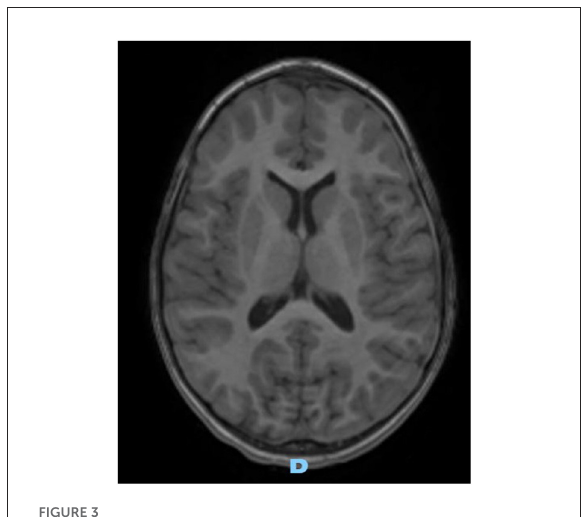
FIGURE3 Axial gadolinium-enhanced T1 MR Image—spontaneous and complete resolution of subdural